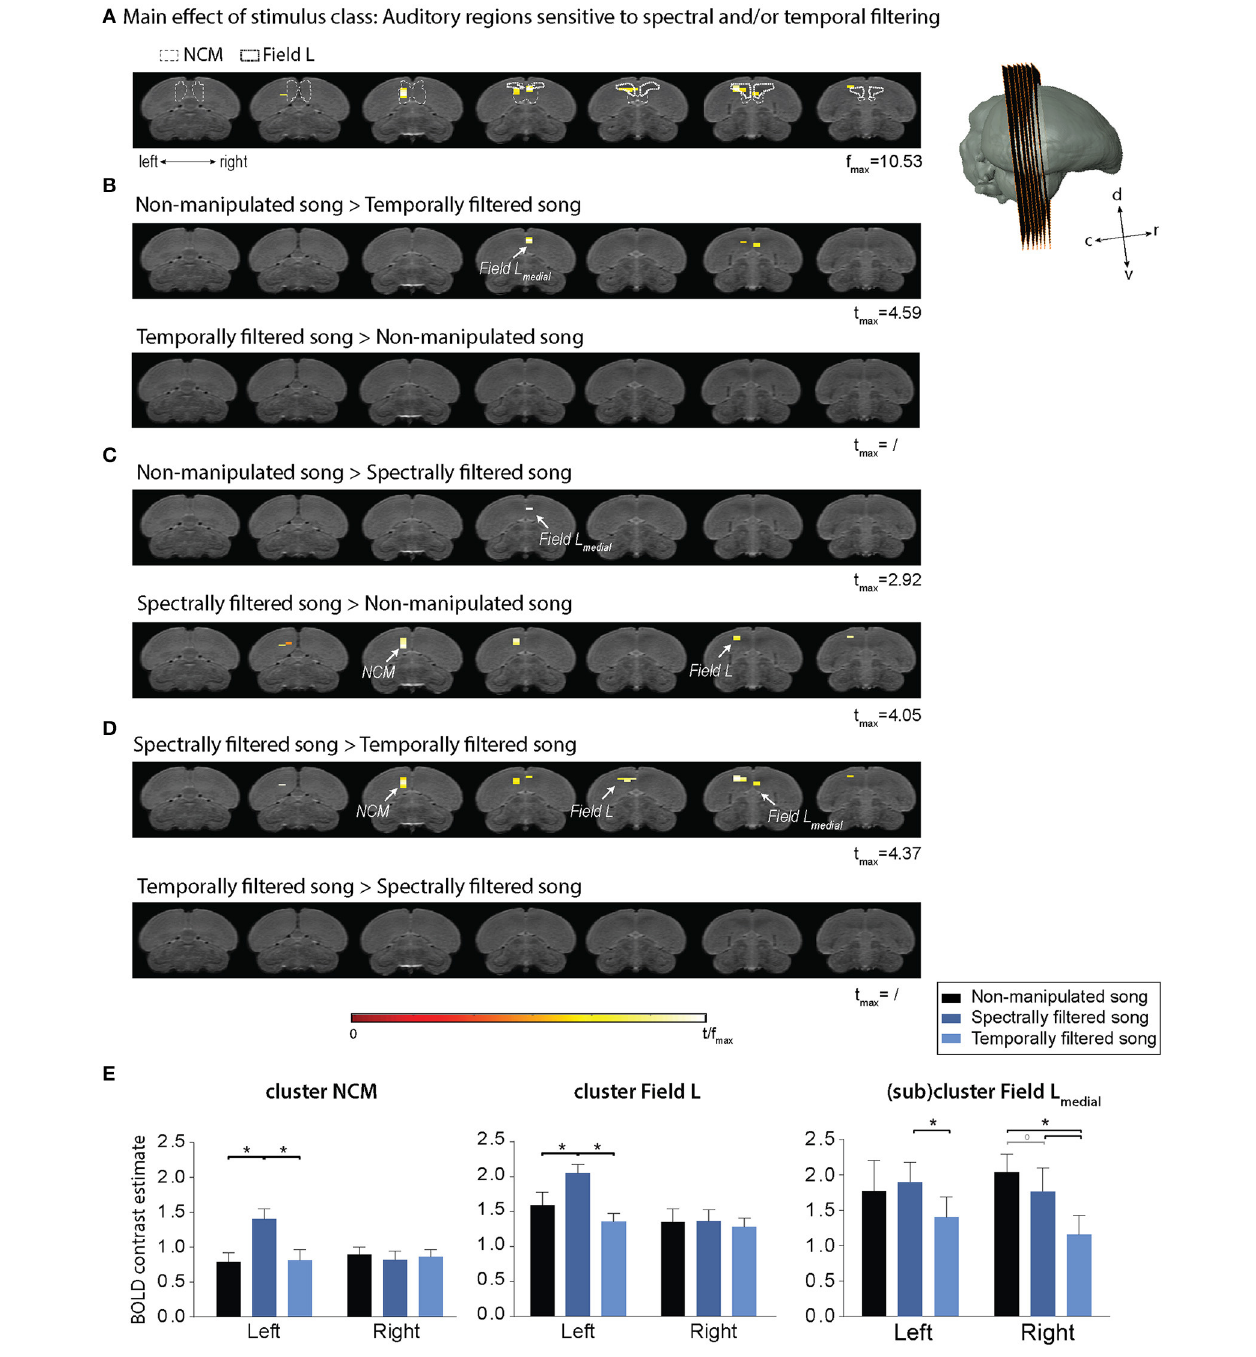
FIGURE 3 | Effect of temporal and spectral filtering of song on neural activation of the auditory forebrain. The image series represents adjacent coronal slices of the population based template with the left image corresponding to the most caudal and the right to the most rostral slice as illustrated by the 3D rendering on the right. Statistical maps are superimposed on the image series. T -values are color coded according to the scale displayed in the figure. All voxels with t > 2.76 ( p uncorrected < 0.005) are displayed. (A) Statistical map of the main effect of stimulus class (one way ANOVA—within subjects). Delineations of two auditory forebrain regions from the zebra finch MRI atlas dataset as published earlier are included as a guide for the localization of the effect (Poirier et al., 2008; van der Kant et al., 2013). (B–D) Statistical maps of all post-hoc t -tests. (E) Average of the estimated relative response amplitude (BOLD contrast estimates ( β ), expressed in non-dimensional units) elicited by playback of non-manipulated song and its corresponding temporally and spectrally filtered variants in the indicated clusters (clusters of significant voxels in different sub-regions as illustrated in the maps above and mirrored counterparts in the opposite hemisphere). The (sub)cluster field L-medial represents the ensemble of voxels within the most medial portion of the large Field L cluster. The zero level corresponds to the estimated mean during rest periods and the error bars to standard errors across voxels in the cluster. c, caudal; d, dorsal; r, rostral; v, ventral; NCM, caudomedial nidopallium (* p FWE < 0.05; ◦ p FWE < 0.10; n = 15).